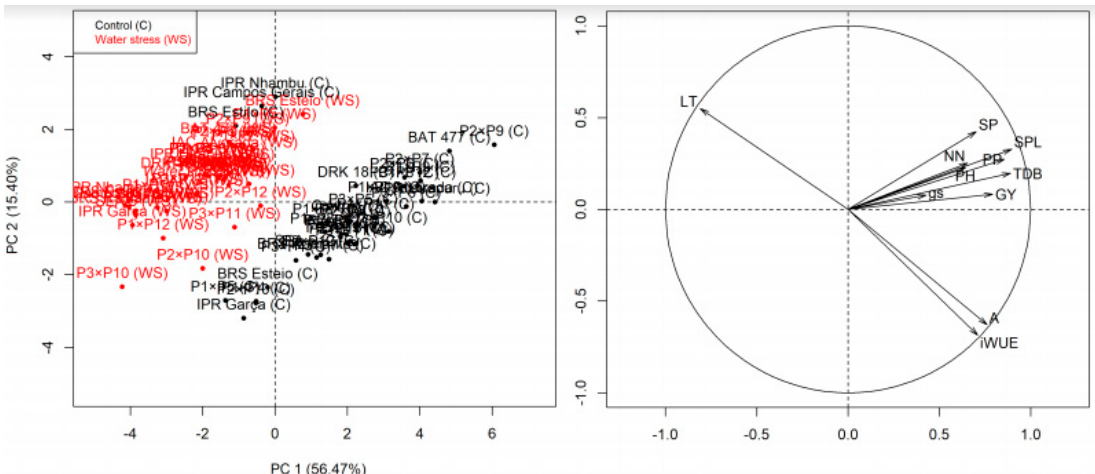
Figure 1. Principal component analysis for agromorphological and physiological traits of the common bean genotypes under water deficit and control condition (well-watered).